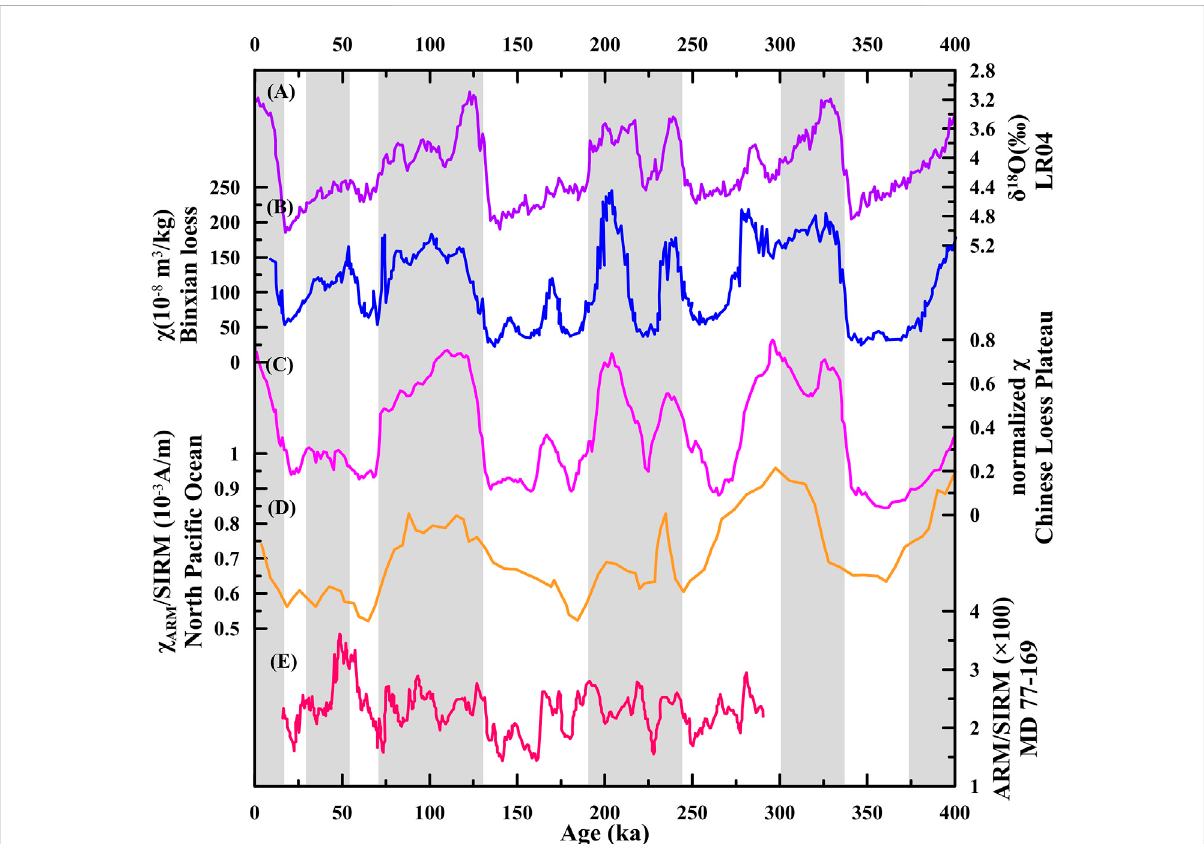
FIGURE 6 Paleo-monsoon records with environmental magnetism during the Late Quaternary. (A) Benthic LR04 δ 18 O stack (Lisiecki and Raymo, 2005); (B) Binxian loess χ lf records (Ao et al., 2020); (C) Normalized χ records from the Chinese Loess Plateau (Nie et al., 2017); (D) χ ARM /SIRM records from core NGC65, North Paci fi c Ocean (Zhang et al., 2019); (E) ARM/SIRM records from core MD 77 – 169, the Andaman Sea (Colin et al.,